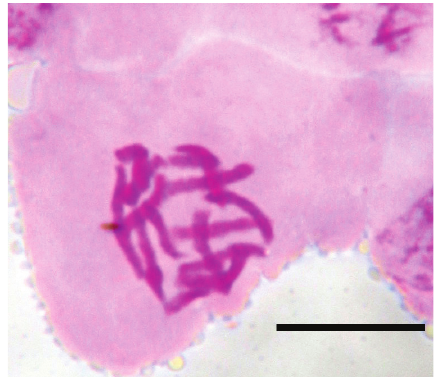
Figure 1. Linum katiae Peruzzi, 2 n = 18. Scale bar: 10 µm.